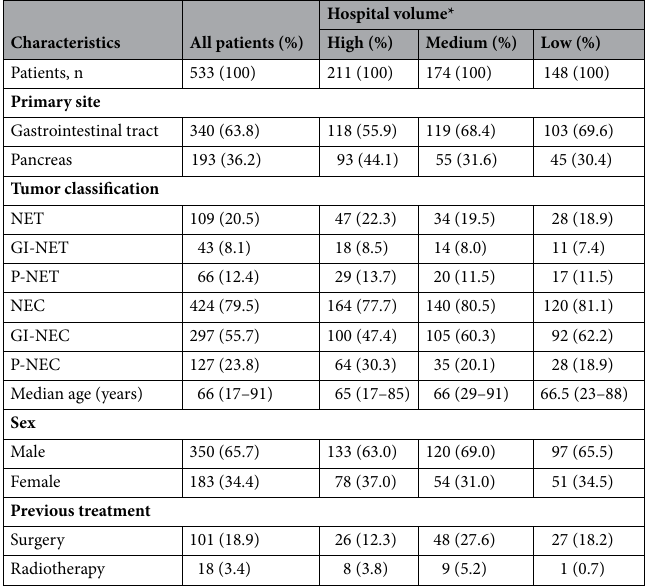
Table 2. Patient characteristics according to hospital volume. GI-NEC gastrointestinal neuroendocrine carcinoma, GI-NET gastrointestinal neuroendocrine tumor, P-NEC pancreatic neuroendocrine carcinoma, P-NET pancreatic neuroendocrine tumor. *Hospital volume was divided into three groups according to number of patients with GEP-NEN treated per year. The upper third of hospitals were designated as high- volume, the middle third as medium-volume, and the lower third as low-volume.